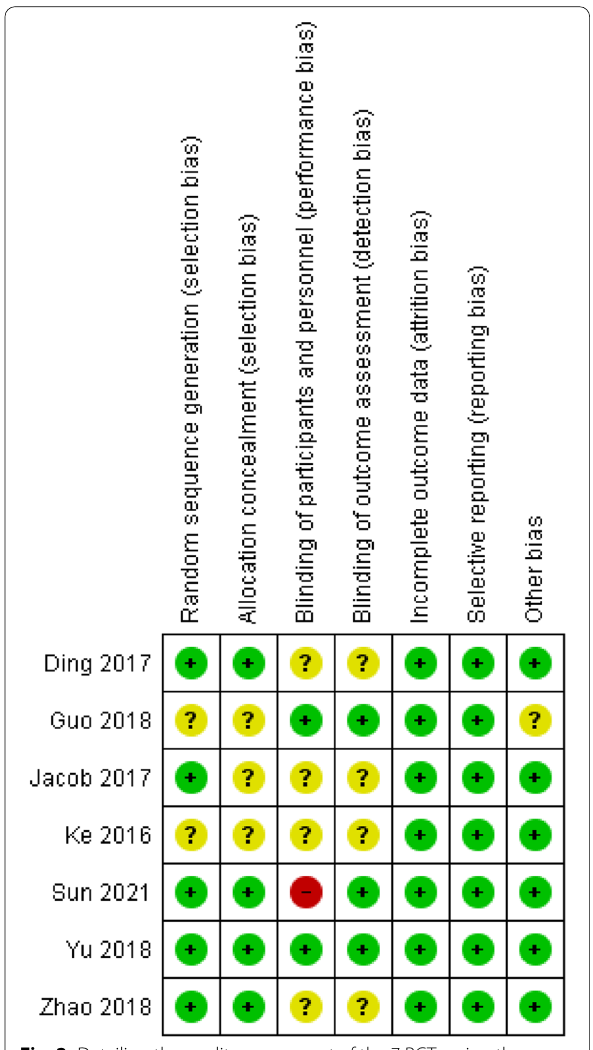
Fig. 2 Detailing the quality assessment of the 7 RCTs using the Cochrane ROB